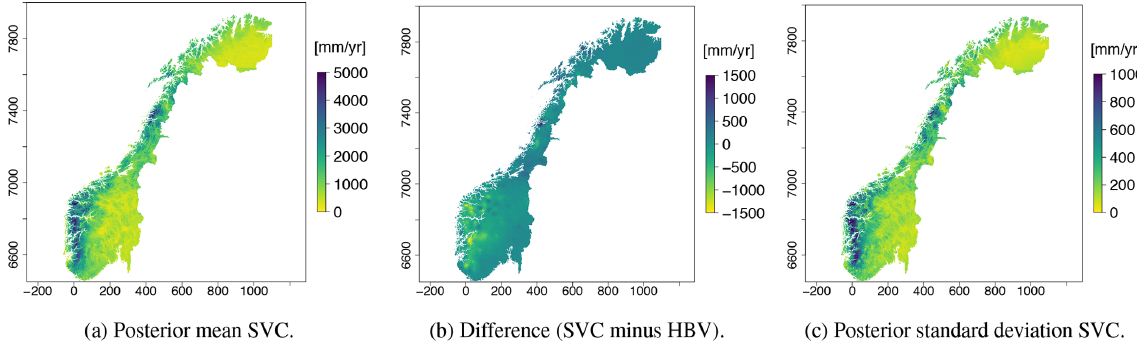
Figure A1. Posterior mean of q( u ) for all grid nodes, difference between the new map and the original HBV map, and posterior standard deviation of q( u ) . The model is fitted without including short records.